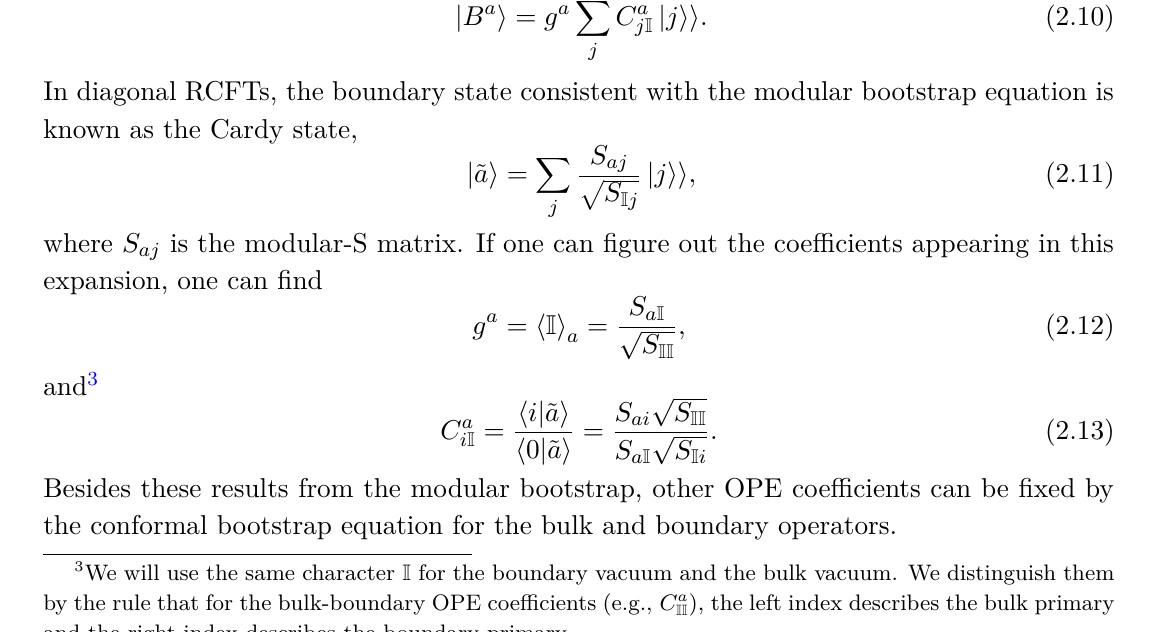
Figure 1 . A boundary primary φ ab the boundary conditions on the two sides of φ ab the primary